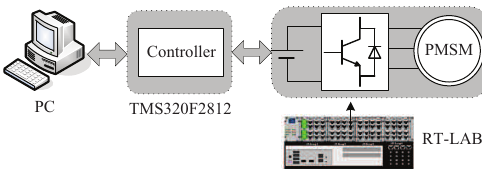
Figure 24. Configuration of the RT-LAB hardware-in-the-loop simulation (HILS) system.